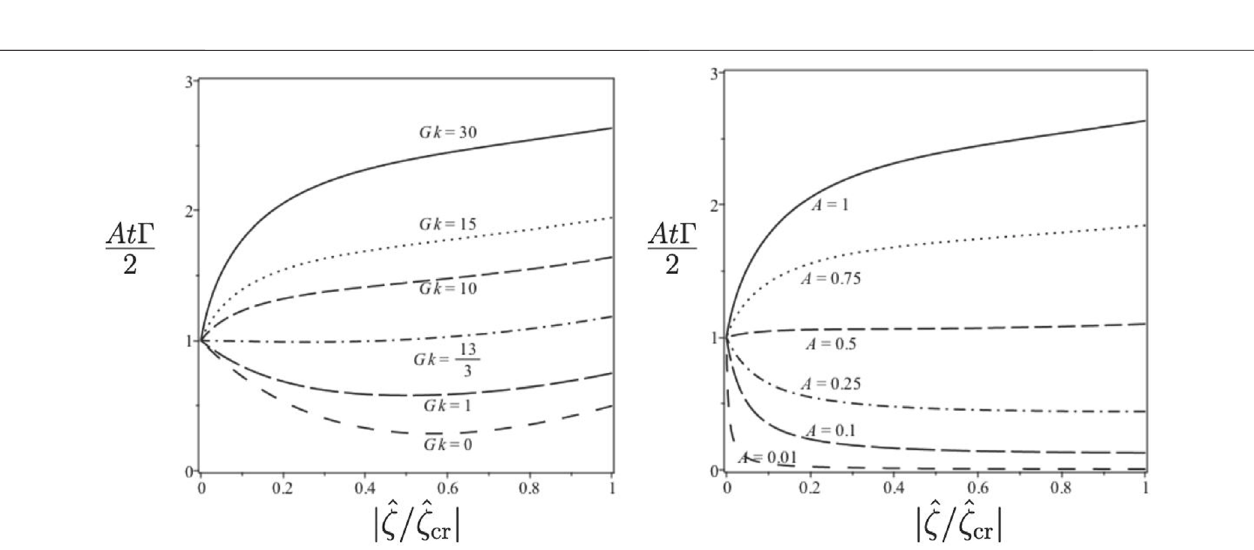
FIGURE 2 | Shear as a function of bubble curvature for various acceleration strengths when A (cid:1) 1, and various Atwood numbers when kG (cid:1) 30.